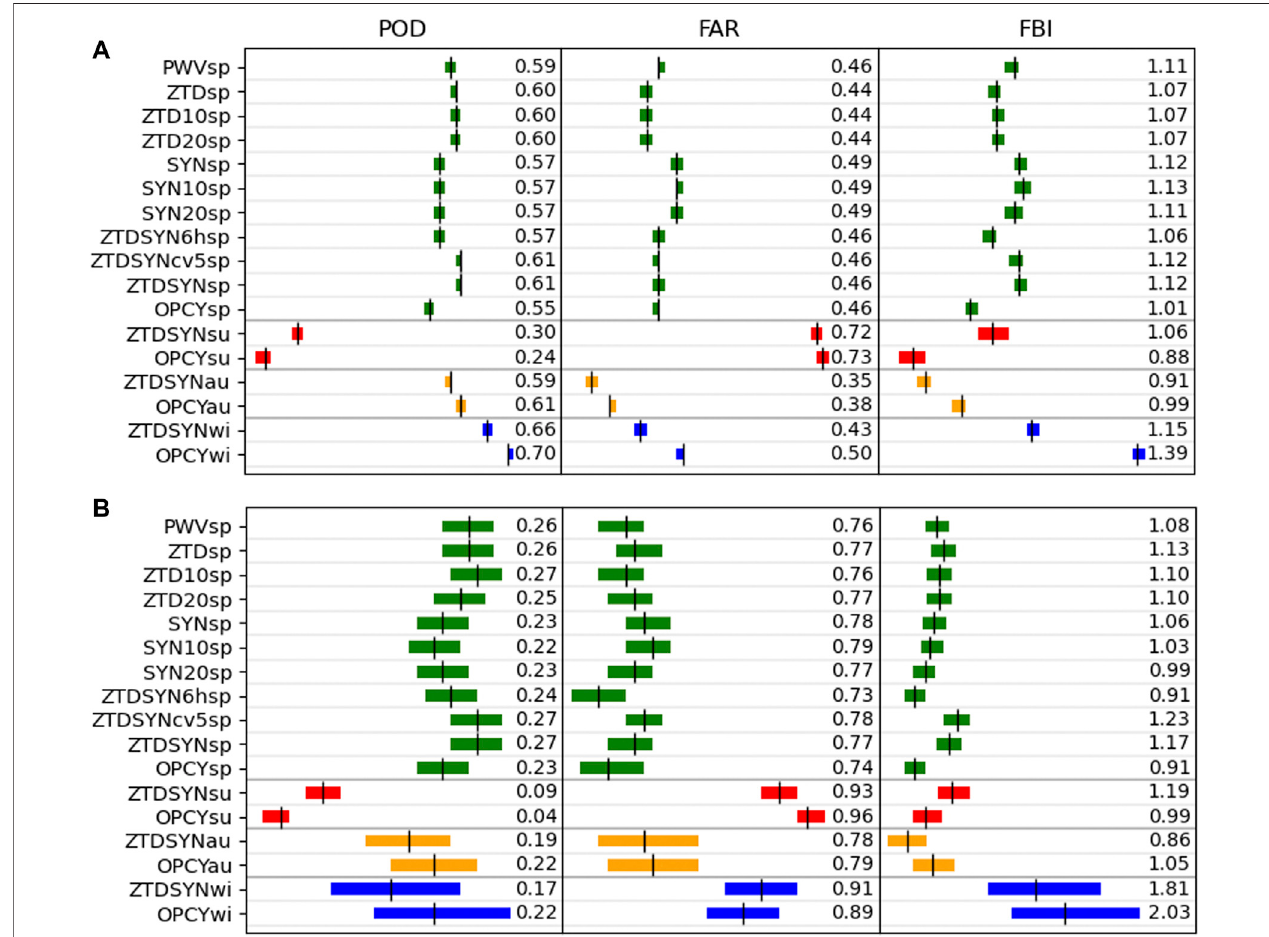
FIGURE 2 | Comparison of all simulations with hourly precipitation amounts at approx. 350 stations regarding POD, FAR and FBI for (A) light rain (0.1 – 2.5 mm/h) and (B) moderate rain (2.5 – 10 mm/h). Con fi dence intervals (95%) of the respective simulation are presented as color bars. With abbreviations representing the assimilatedobservations:e.g.,OPCY,opencycle;ZTDSYN,synopticandZTDdatawiththefollowingadditions: 10 (thinningdistanceof10 km), 6h (6 hcyclingrate), cv5 ( cv5 BE option), sp , su , au , and wi (spring, summer, autumn, and winter).